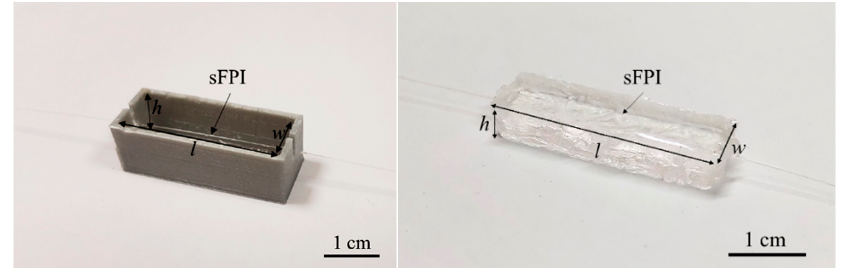
Figure 2. Load cell production apparatus and the resulting load cells. sFPI stands for the sensing FPI, which comprises the two different load cells (LC 1 or LC 2 ), and l , h and w are the cell’s length, height and width, respectively.